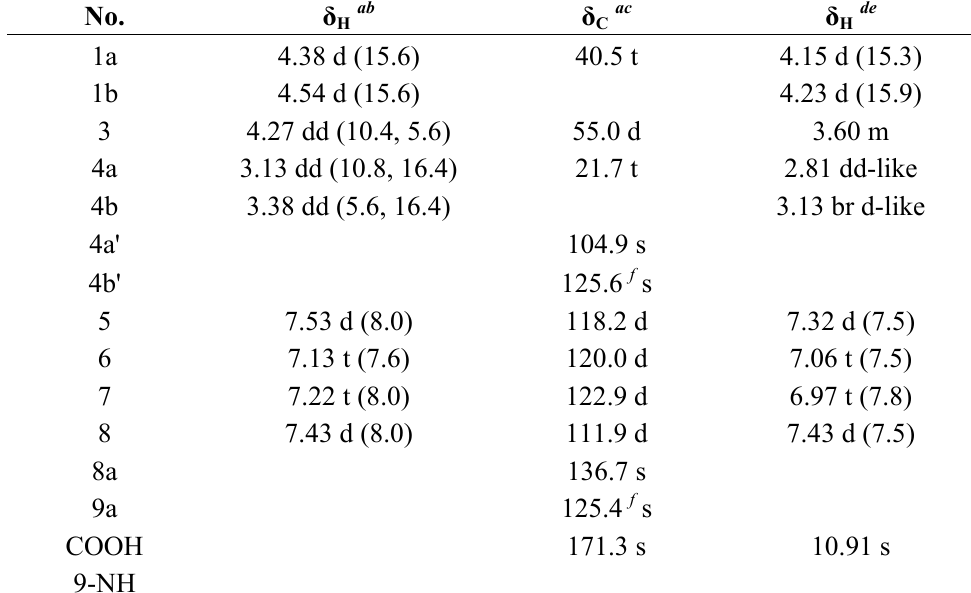
Table 1. 1 H and 13 C-NMR spectroscopic data of compound 1